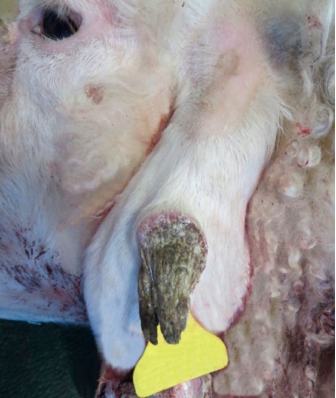
Figure 1. Left pinna: horn-like exophytic cutaneous